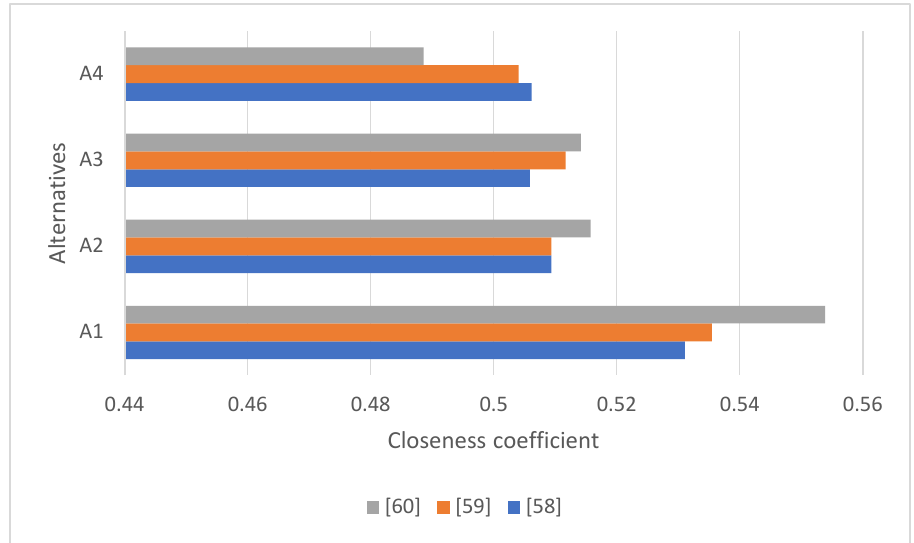
Figure 7. Calculation of closeness coefficient according to [58 – 60].